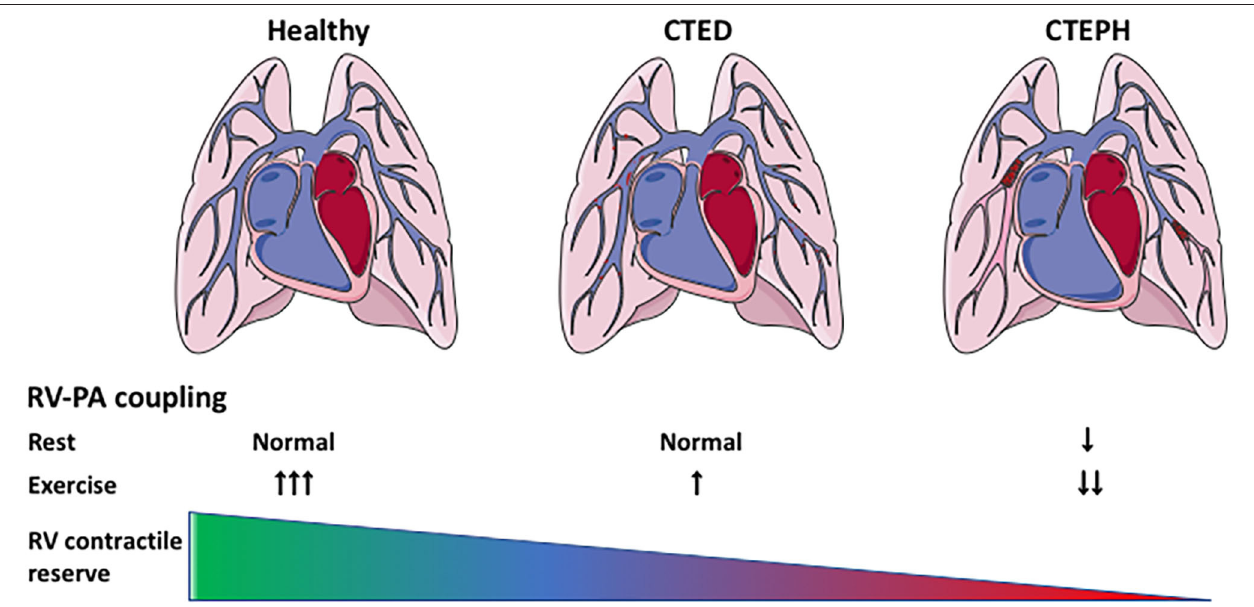
FIGURE 1 | Cardiac remodeling and reserve in CTEPH. Cardiac remodeling in CTEPH, and the effects of exercise on the cardiac reserve. CTED, chronic thrombo-embolic disease; CTEPH, chronic thrombo-embolic pulmonary hypertension; RV-PA coupling: right ventricular-pulmonary artery coupling.